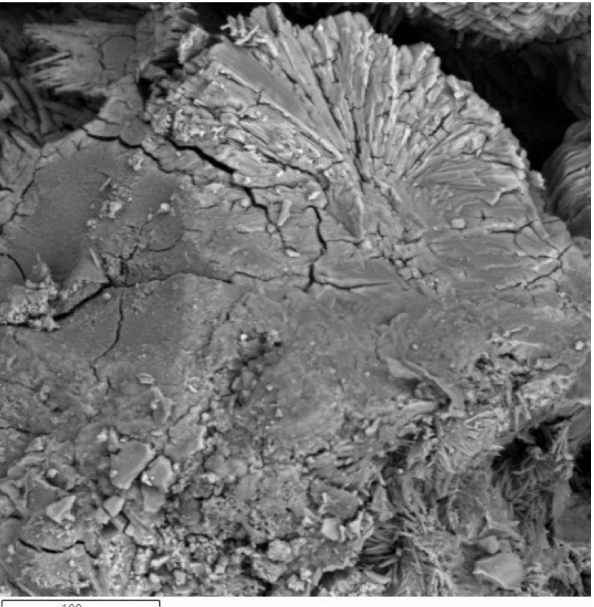
Figure 6. SEM image of the MPP